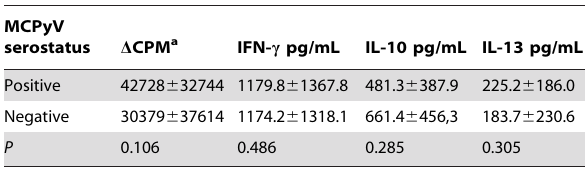
Table 4. Comparison of Candida albicans -specific proliferation and cytokine responses among MCPyV seropositive and –seronegative subjects at 2.5 m g/ml antigen concentration.